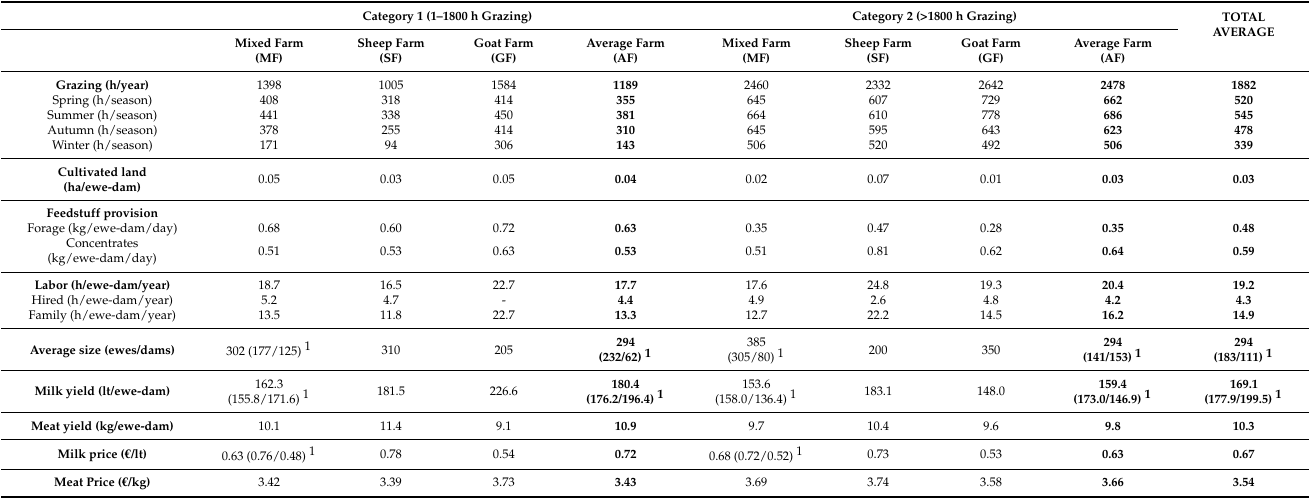
Table 2. Basic technical and economic indicators of the sample per farm Category and